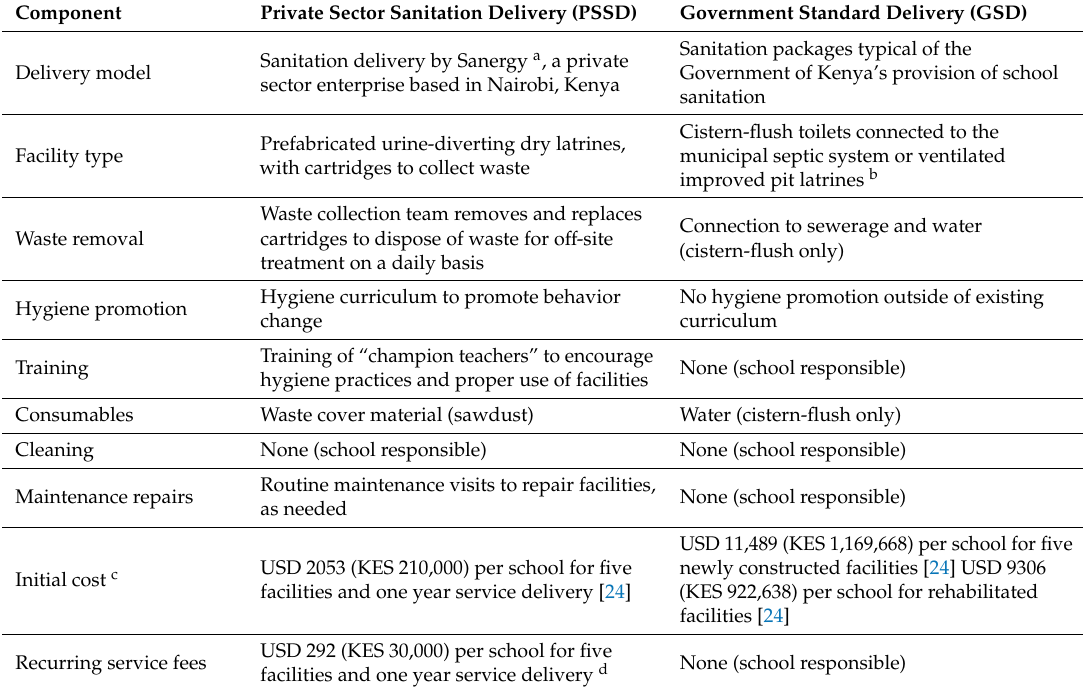
Table 1. Summary details of private sector sanitation delivery and government standard delivery of sanitation for trial